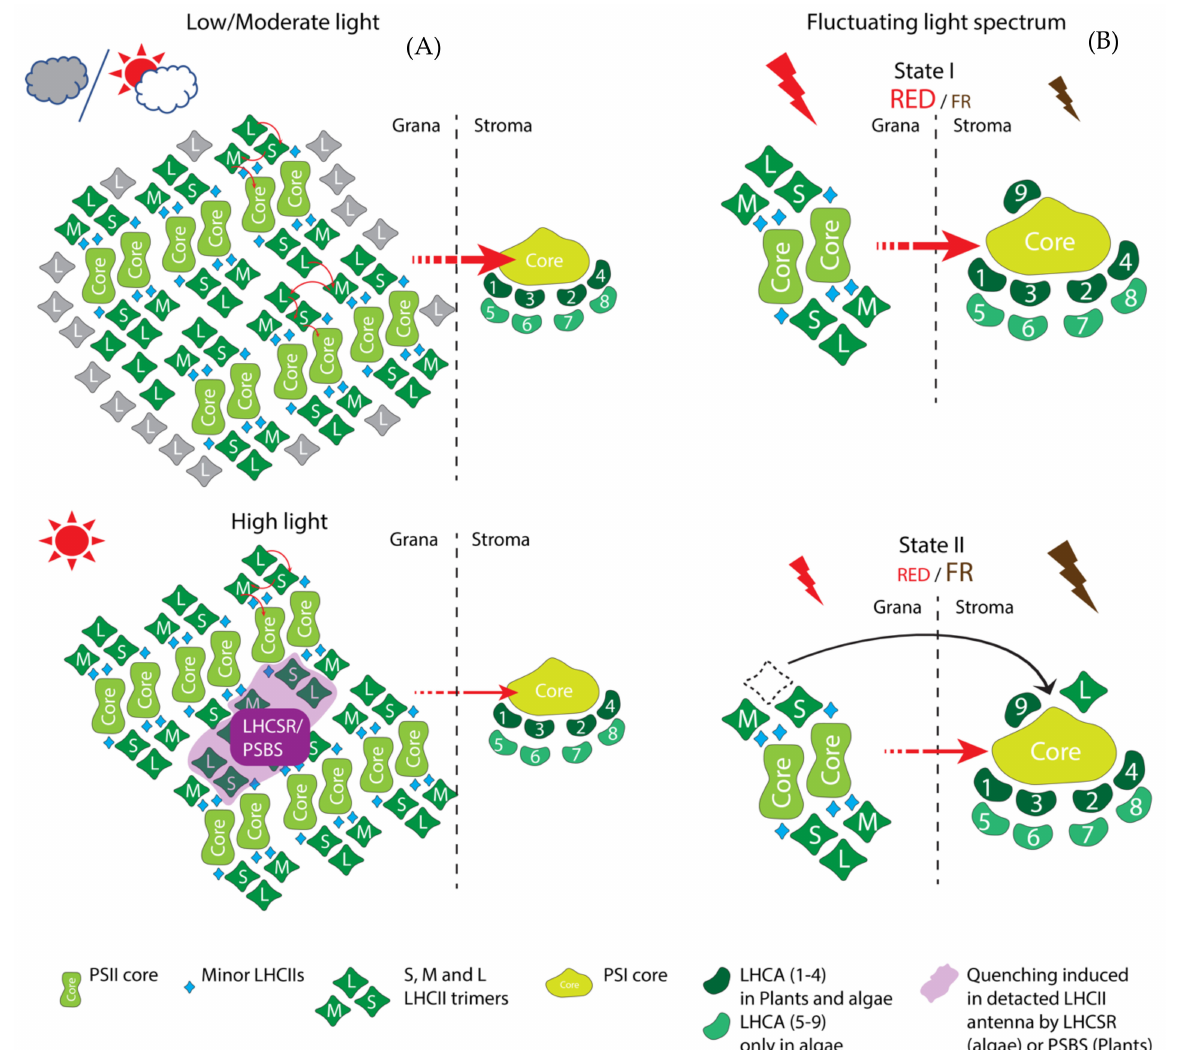
Figure 3. Functional insight into green algae and the plant antenna (Lhc) and the photoprotection proteins. ( A ) In low or moderate light, maximum energy from sunlight is harvested and channelled to PSI for downstream mechanisms photosynthesis. Loosely bound LCHII L trimers (in grey) associate with PSII and increase the antenna size in low light conditions or in shaded leaves. ( B ). In high light conditions, the LhcII antenna system is quenched by either the LhcSR (in algae) or the PsbS (in higher plants). This prevents the over-excitation of the PSI as less energy is harvested by PSII. ( C ) The shift from red to far red-light causes L trimers from PSII–LhcII complexes to move to PSI where they serve to increase the PSI antenna size as far-red light preferentially excites